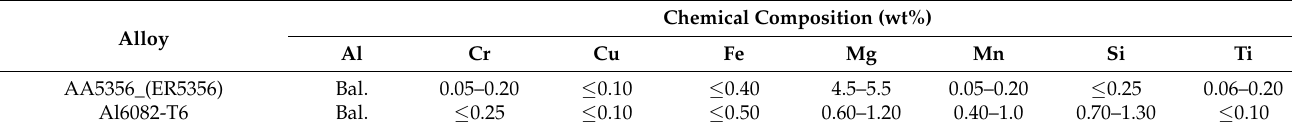
Table 1. Chemical composition of welding materials.